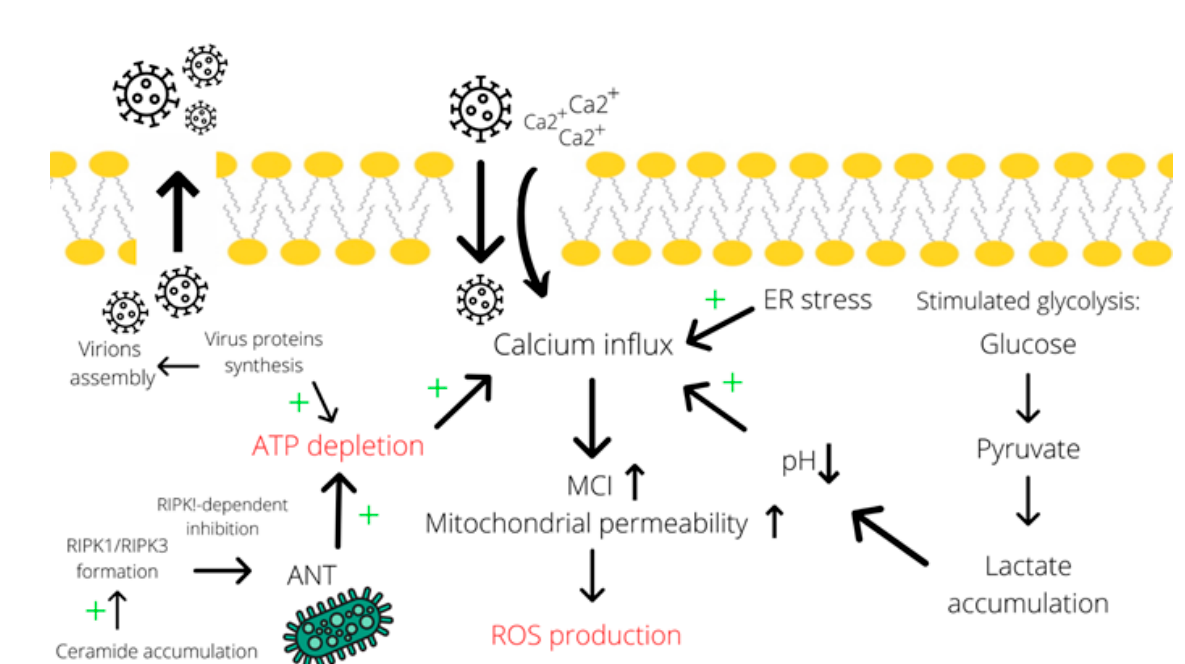
Figure 2. Calcium influx contributes to the induction of necrotic cell death. Calcium influx is promoted by many factors, including endoplasmic reticulum stress, acidosis (due to lactate accumulation) [70,71], and ATP depletion (particularly due to assembly of virions and RIPK1-dependent inhibition of ANT in the mitochondrial membrane mediated by ceramide accumulation). Subsequently, an elevated concentration of calcium induces ROS production through increasing mitochon- drial permeability [56,72,73]. A simultaneous decrease in ATP levels and the induced ROS production result in necrotic cell death. Abbreviations: ER—endoplasmic reticulum, ANT—adenosine nucleotide translocase, MCI—mitochondrial complex I, LDH—lactate dehydrogenase, “+”—increase effect.